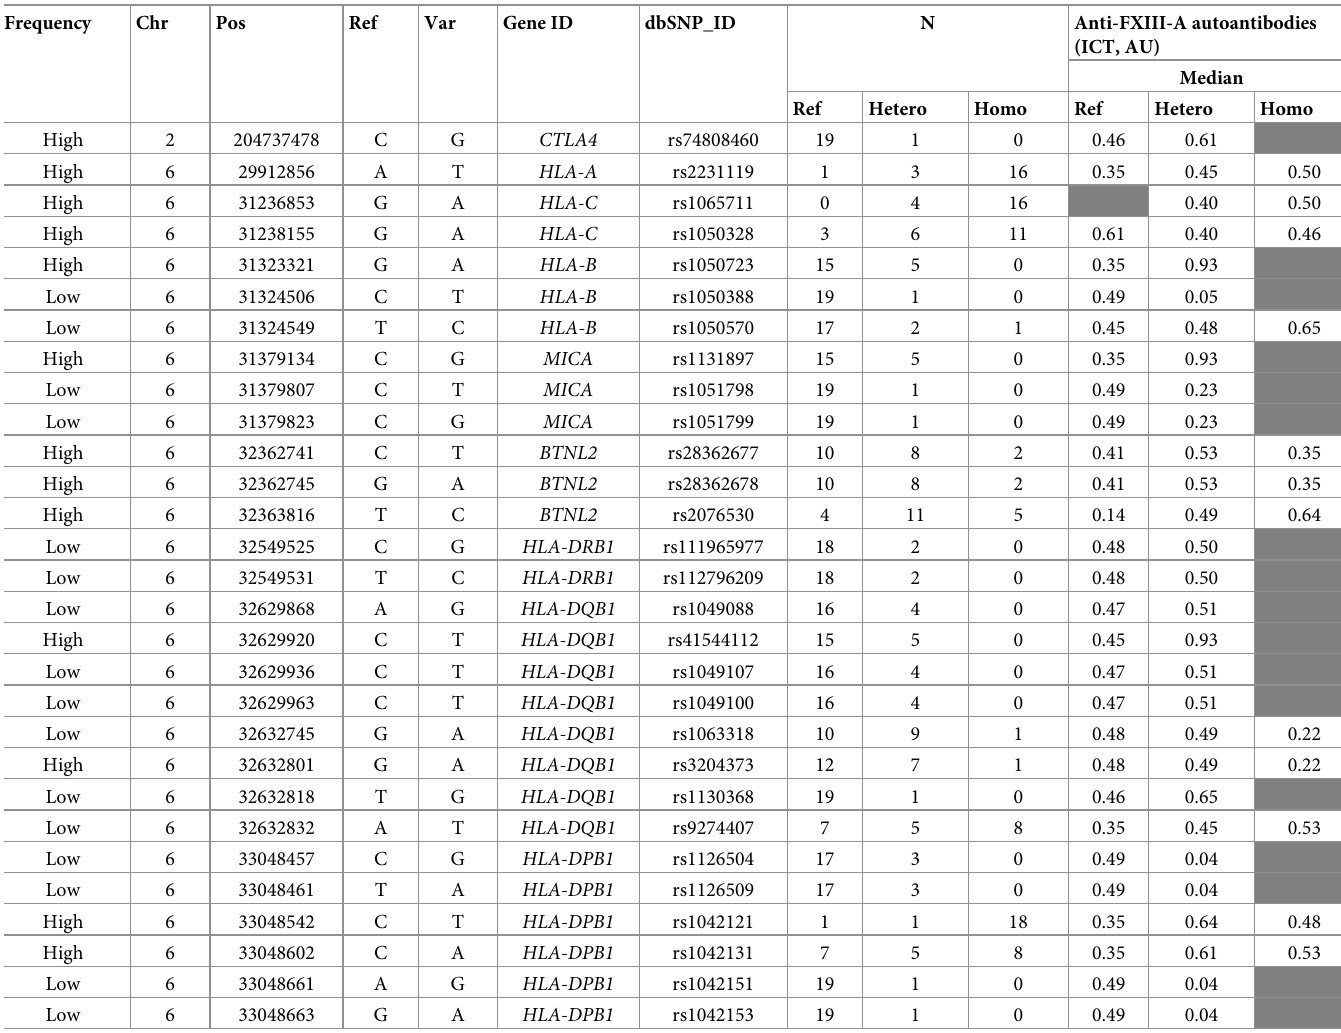
Table 5. Anti-FXIII-A autoantibodies measured by ICT in each genotypes of MHC class I and II molecules and their associated